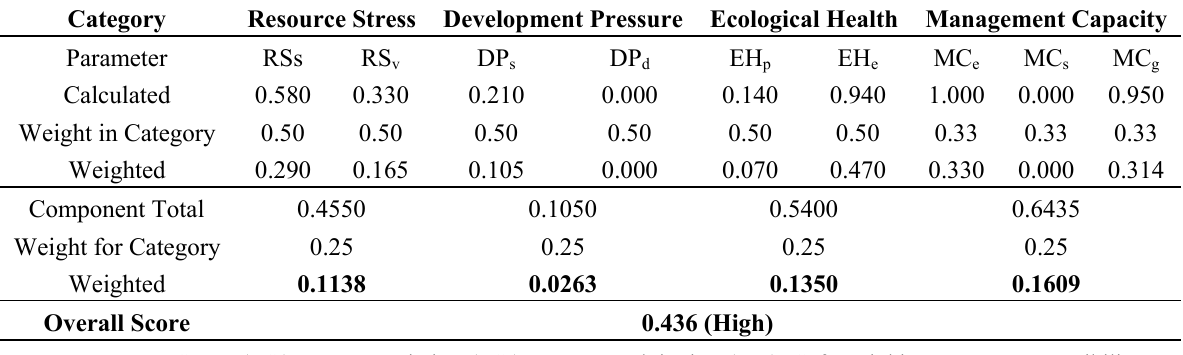
Table 3. Calculated Vulnerability Index with various categories and parameters for the water resources of the study